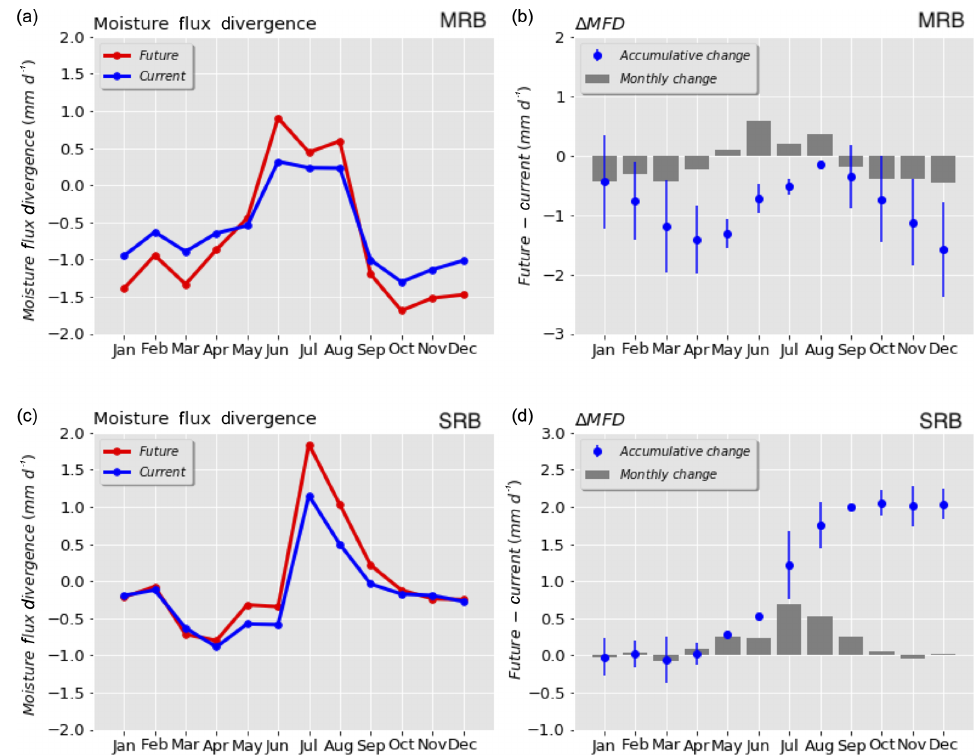
Figure 8. Changes in atmospheric water vapour divergence (mmd − 1 ) for each calendar month between WRF–PGW and WRF–CTL over MRB (a, b) and SRB (c, d)